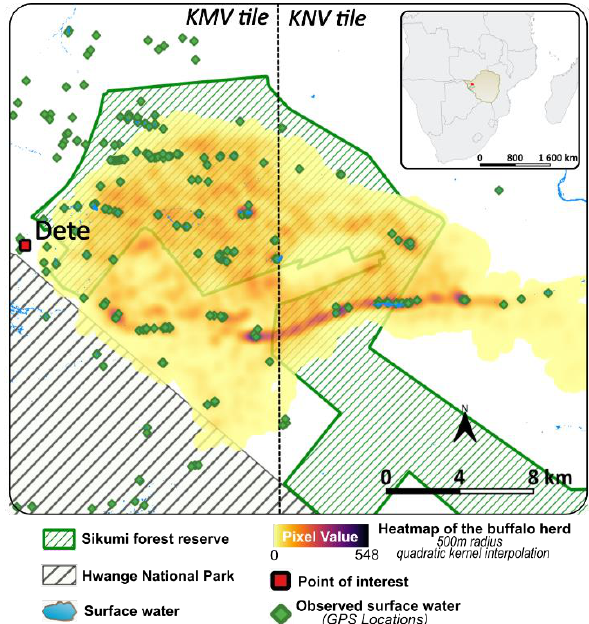
Figure 1. Map of the study area and display of the data used in the